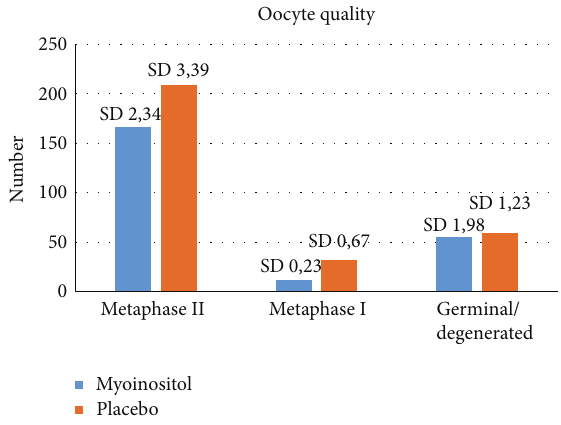
Figure 3: Oocyte quality and treatment with myoinositol or placebo ( 𝑝 = 0.06 ).